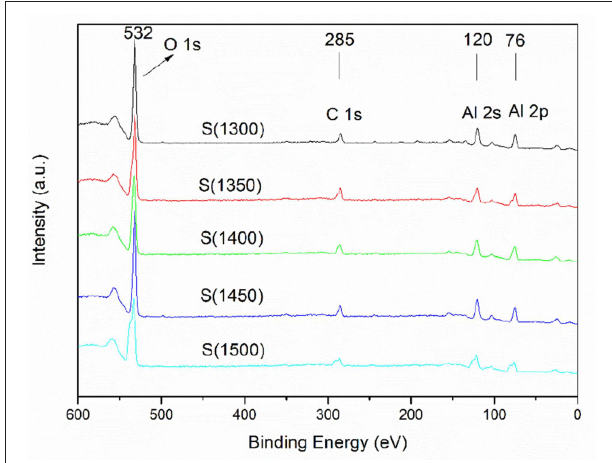
FIGURE 8 | XPS curves of alumina ceramics.